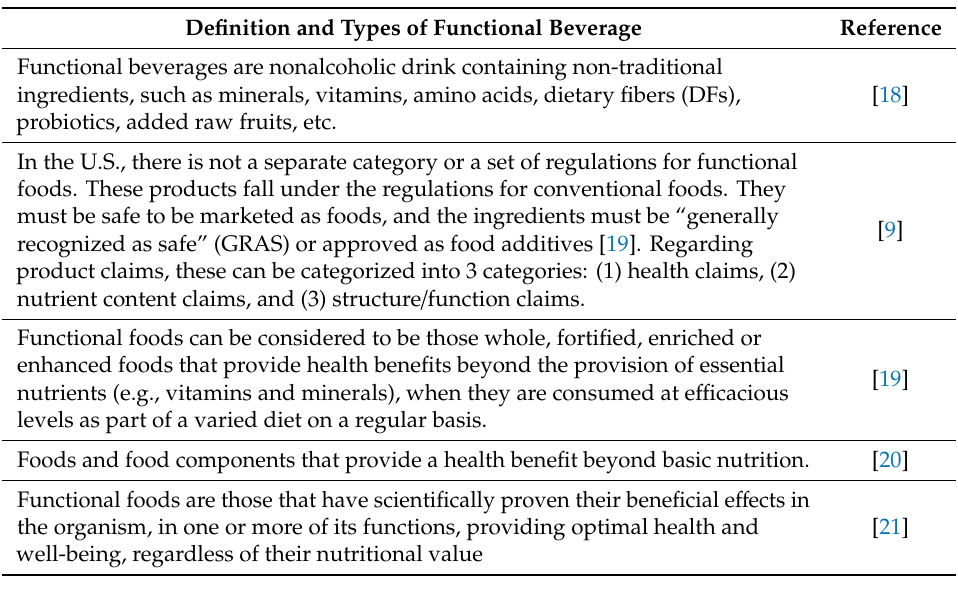
Table 1. Definition of ‘Functional food / beverage’ from